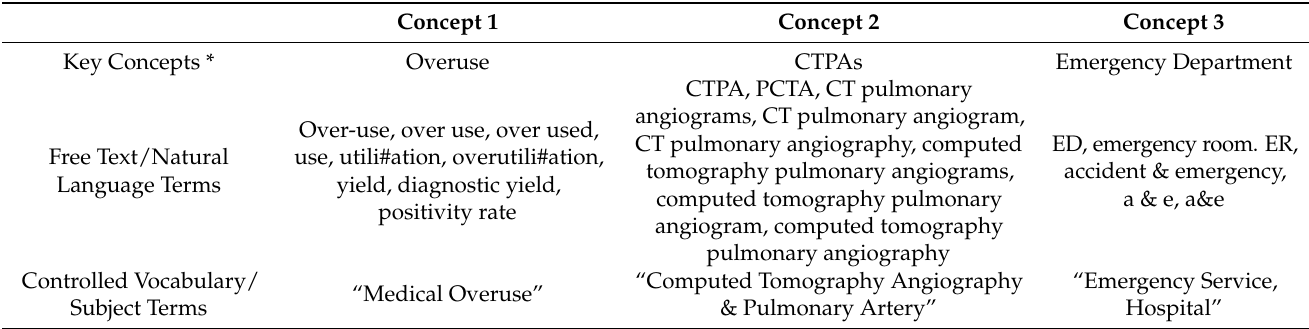
Table 1. Concept & Keyword Mapping